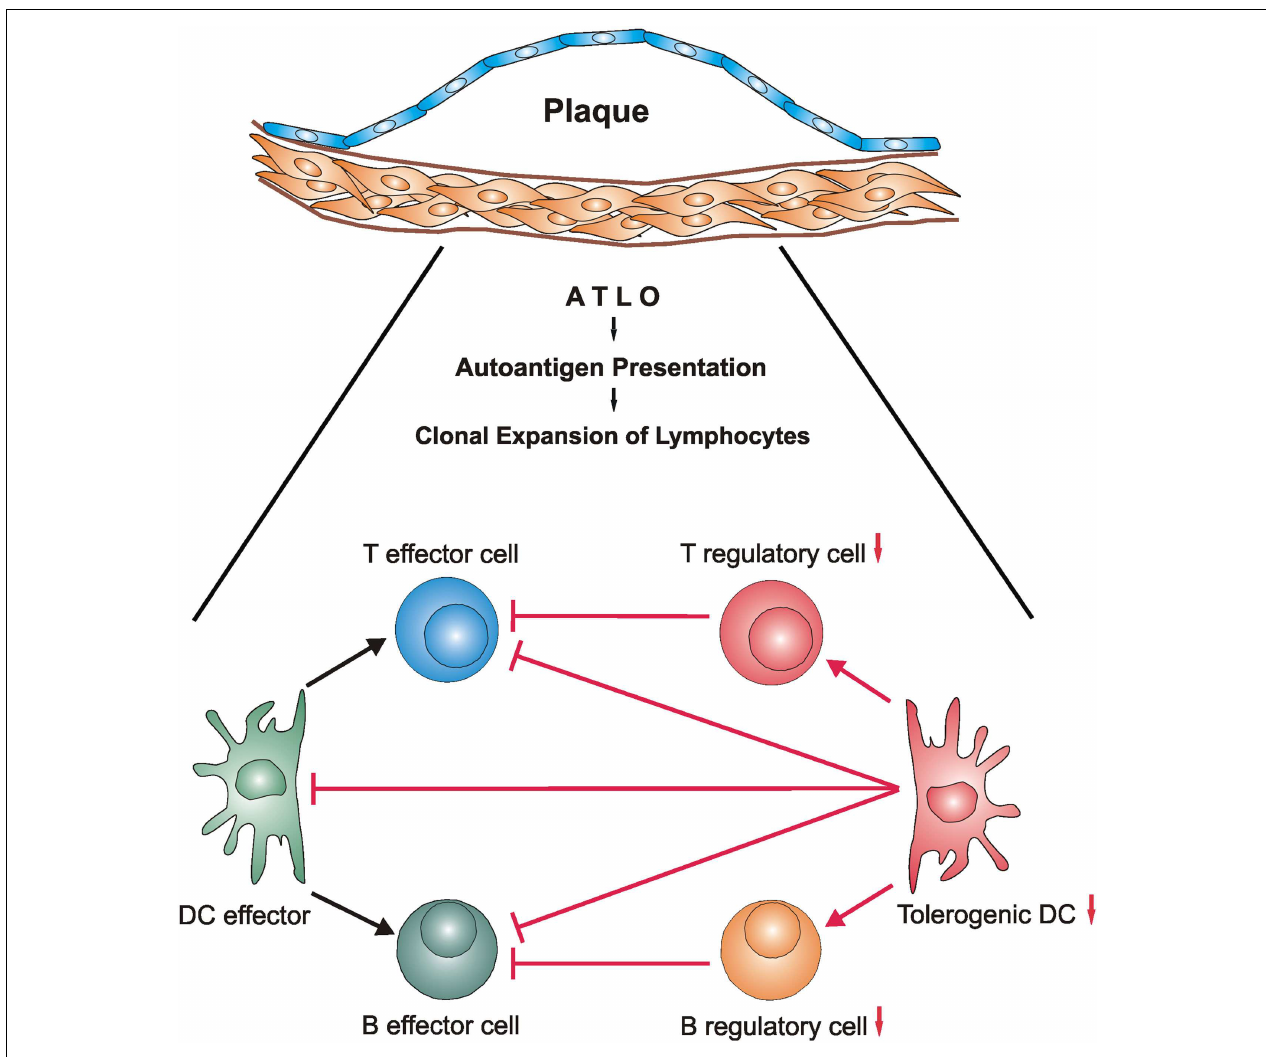
compromise activity of their suppressors. Although mechanisms of unstable plaque formation are poorly understood in atherosclerosis, mechanisms of autoimmune injury of brain and other organs are better understood. By analogy, autoimmuneT cells may contribute to the formation of vulnerable/unstable plaques during clinically significant atherosclerosis. Definition of molecular mechanisms of the emergence of autoreactivity from inflammation and the conversion of autoreactivity to autoimmune disease in atherosclerosis and other bona fide autoimmune diseases has a major potential to identify therapeutic targets. Note that innate immune cells and their dichotomic subtypes including innate B1-a/B1-b cells, naturalT regulatory cells, and macrophage subtypes are not depicted in this scenario but aspects of their functional impact are subject to reviews in this series. Additional cell/cell interactions and marker expression of effectors or suppressors are not shown for ease of